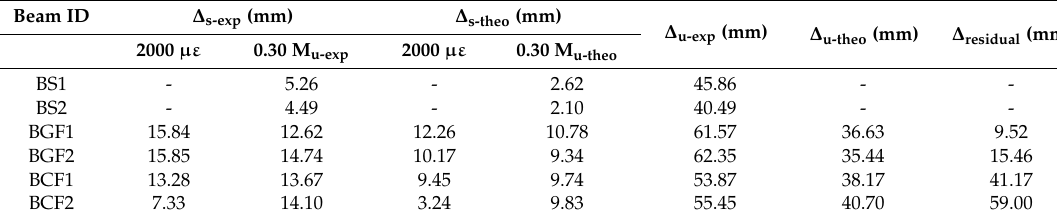
Table 7. Theoretical and experimental mid-span deflection.